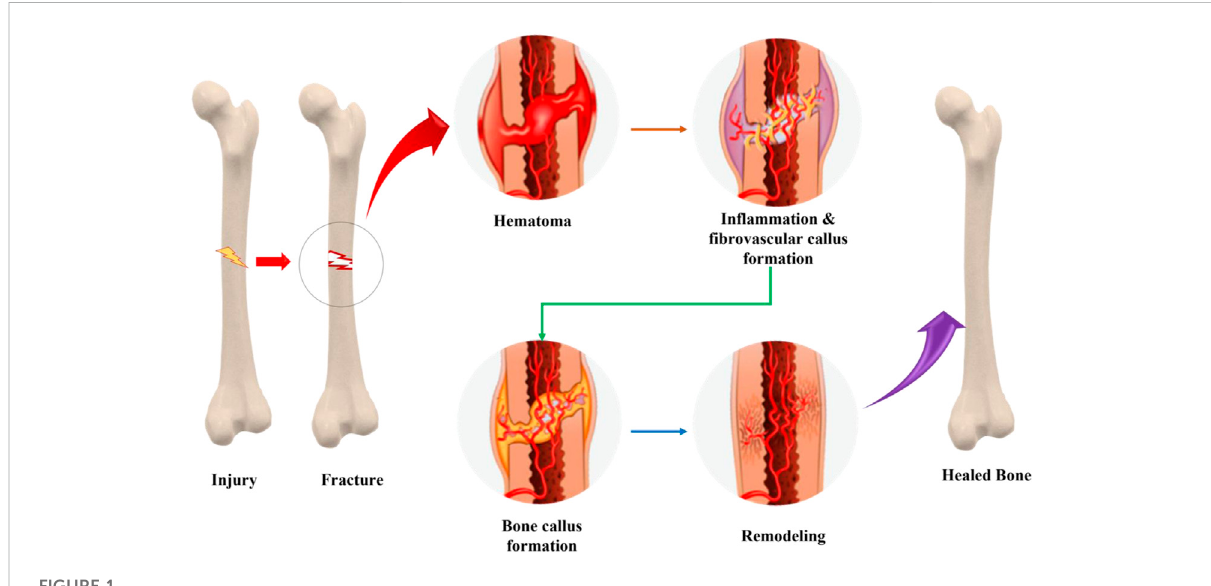
FIGURE 1 Process of fracture healing and mechanism involved in complete bone healing.